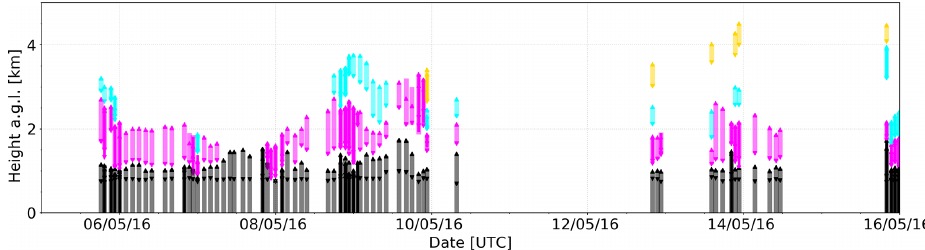
Figure 2. Layer definition during the measurement period 5–15 May 2016. The definition of layers is explained in Sect. 3. Colors mark the upper layers, which were not used for further analysis. Triangles mark the lower and upper limits of the area used for